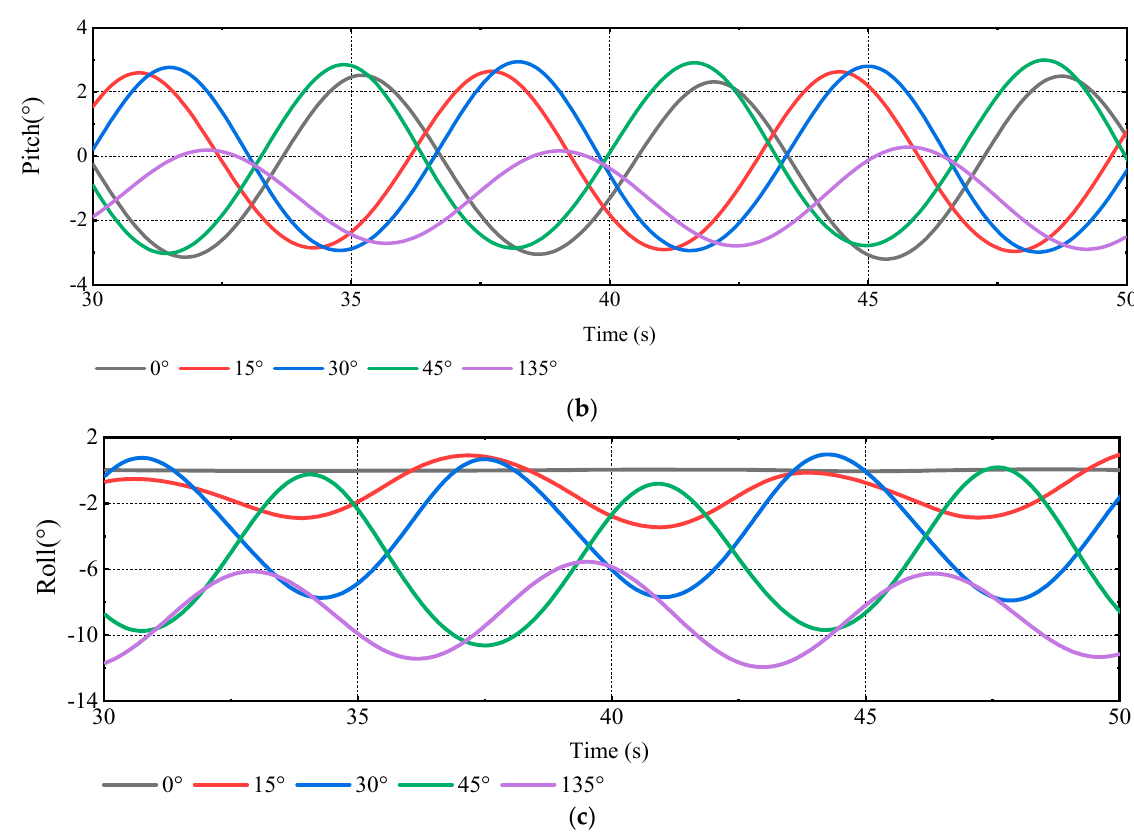
Figure 15. Time histories of motion at different wave heading angles ( v = 6.5 m/s). ( a ) Heave; ( b ) Pitch; ( c ) Roll.